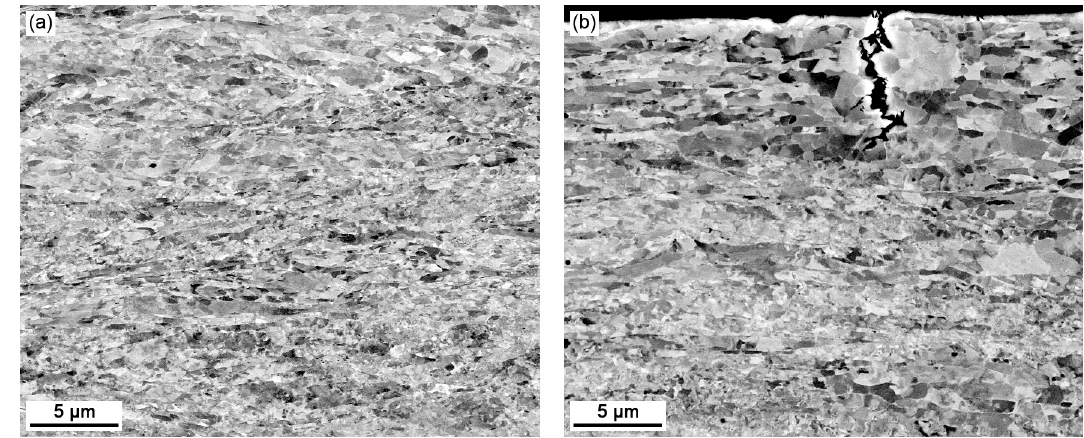
Figure 2. Electron channeling contrast images of fatigue tested ARMCO ® iron ( N f = 7 × 10 5 ) processed by one ECAP pass followed by 64% cold rolling ( a ) at the neutral fiber of the rotating bending specimen and ( b ) at the surface of the smallest cross ‐ section.